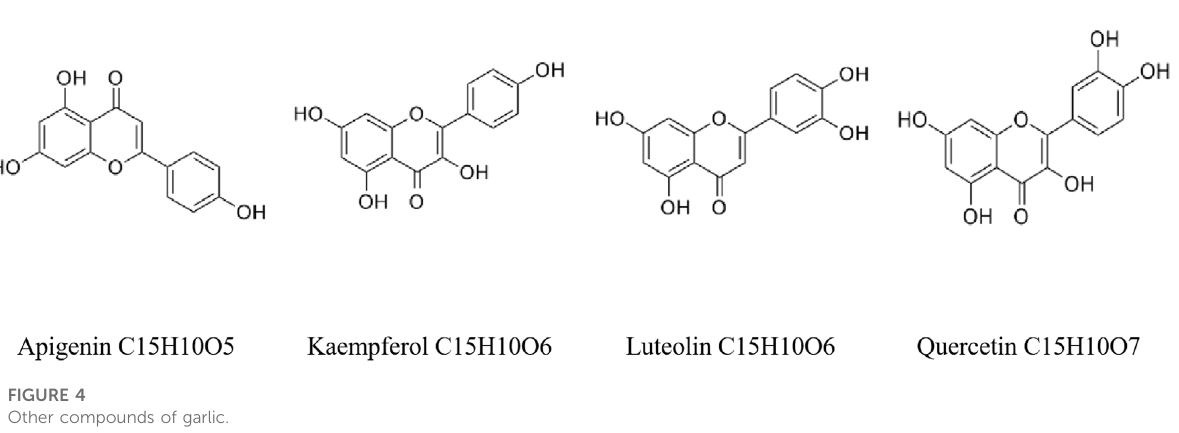
FIGURE 4 Other compounds of